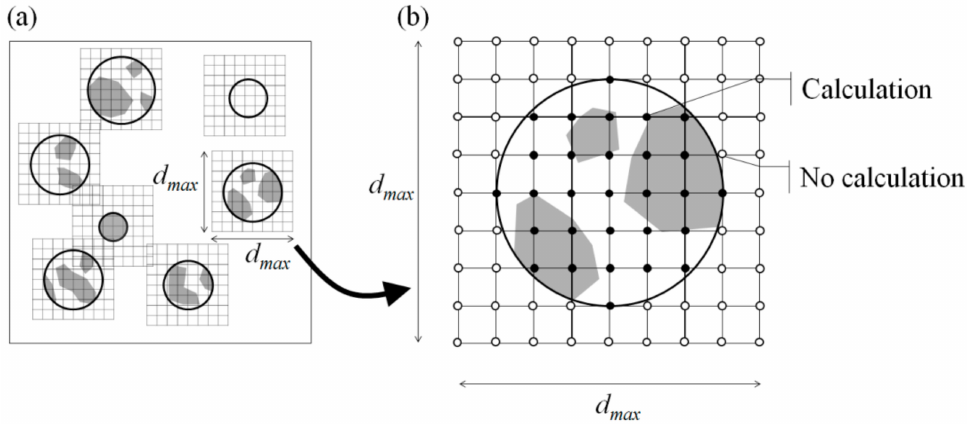
Figure 6. Calculation procedure of the spatial gray level dependence method and gray level difference method: ( a ) superimposition of a square of size d max on the particle sections; ( b ) even subdivision of the square into small squares, and calculation of the points encompassed by the particle